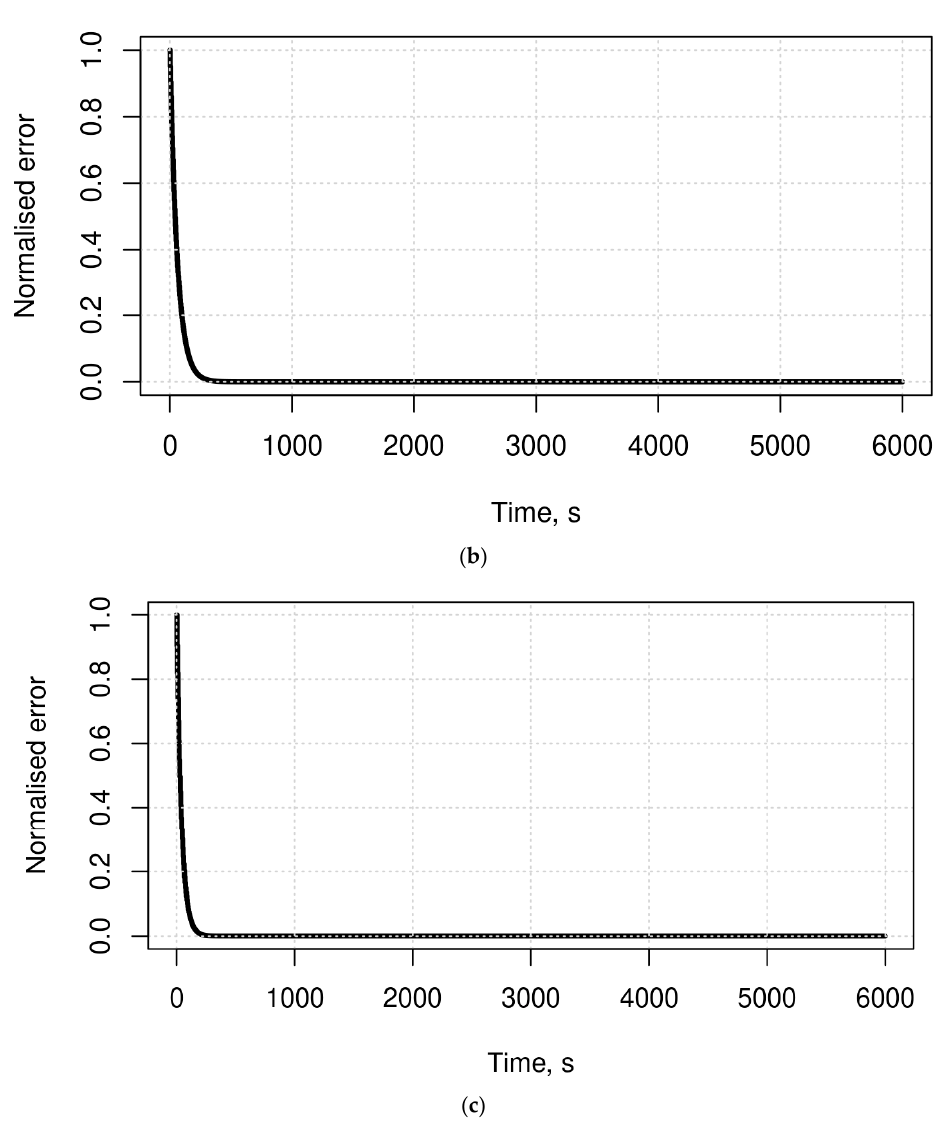
Figure 4. Normalised error versus time of ( a ) BoT-IoT, ( b ) IoTID20, and ( c ) TON-IoT.